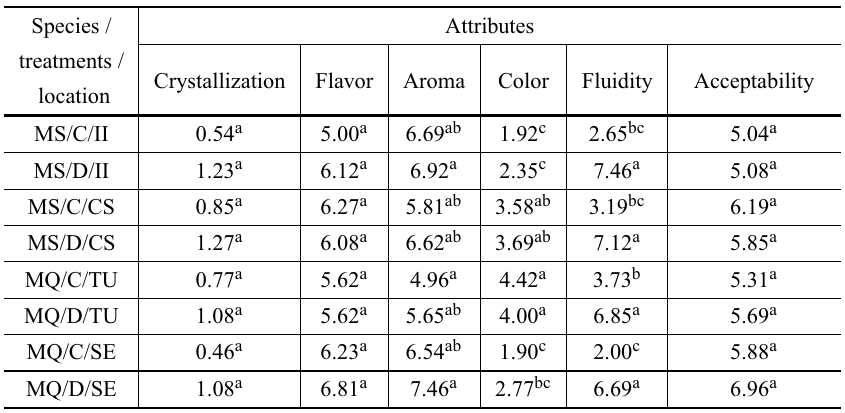
Mean values for sensory attributes found in honey samples of Melipona scutellaris (MS) and Melipona quadrifasciata (MQ), either fresh or submitted to a dehumidification